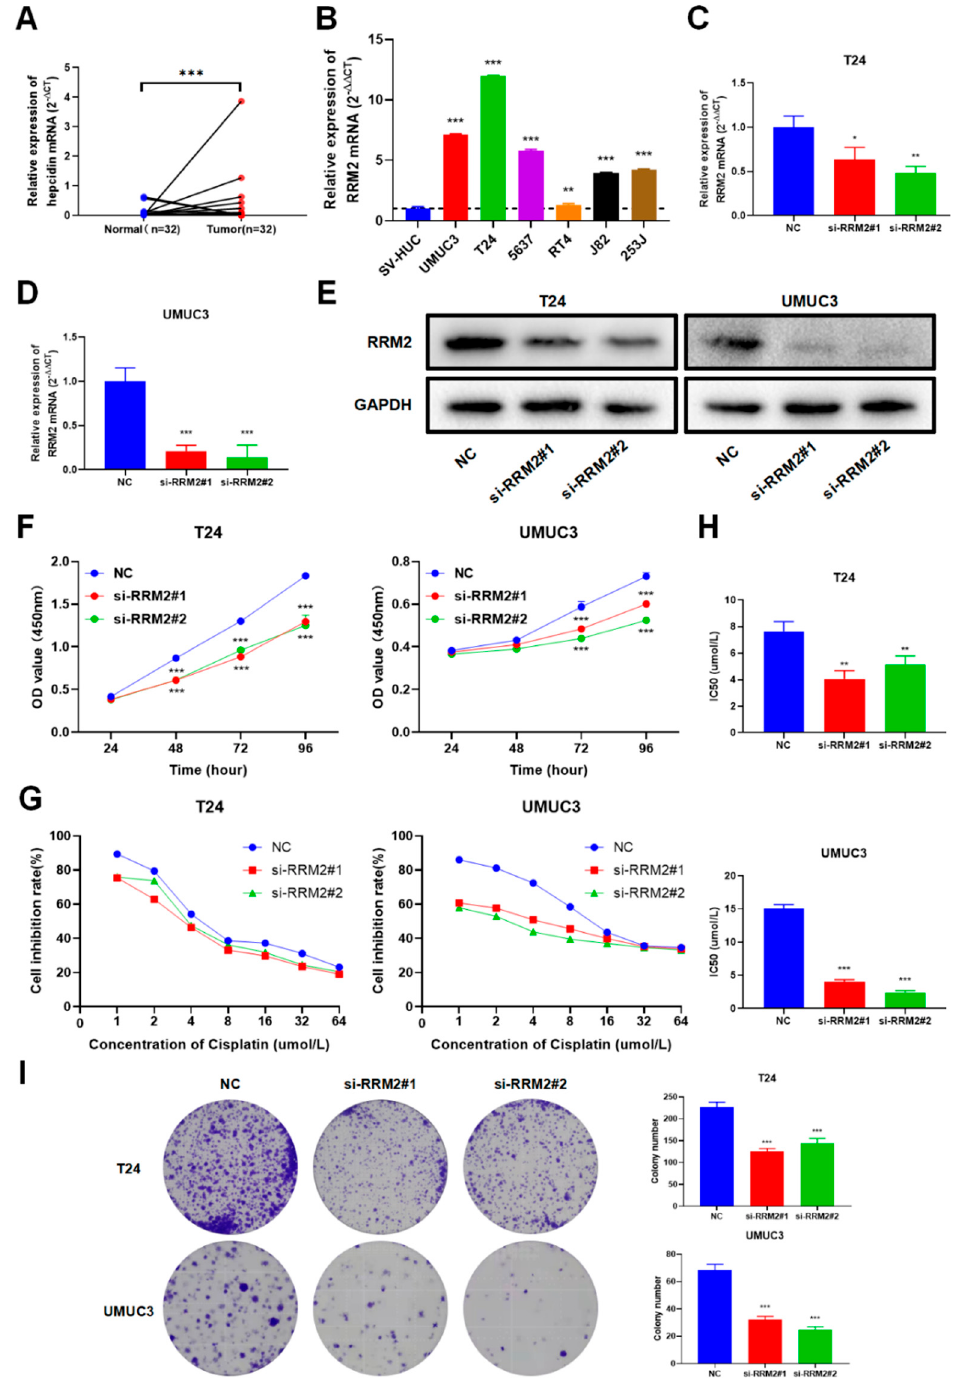
Figure 10. Expression and function of RRM2 in BLCA. ( A , B ) RRM2 mRNA expression in BLCA paired tissues ( A ) and cell lines ( B ). ( C – E ) RRM2 siRNA transfection efficiency was detected by qRT- PCR ( C , D ) and western blot ( E ). ( F ) T24 and UMUC3 cells’ growth and proliferation was explored by CCK-8 assays. ( G , H ) Down-expression of RRM2 could enhance the sensitivity of T24 and UMUC3 cells to cisplatin ( G ) and the bar graphs of IC50 were presented ( H ). ( I ) Blocking RRM2 expression could decrease the colony number of T24 and UMUC3 cells. (* p < 0.05, ** p < 0.01, *** p < 0.001)